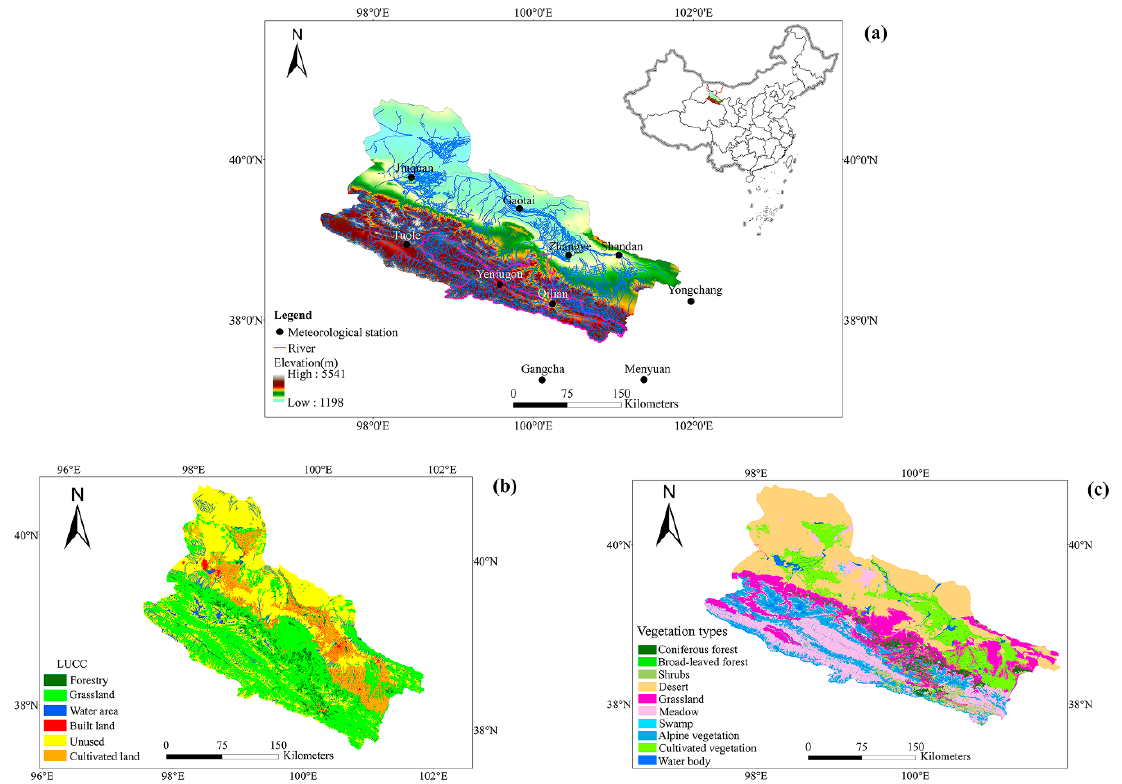
Figure 1. Location and meteorological stations ( a ), land use / cover (LUCC) for 2011 ( b ), and vegetation for 2011 ( c ) in the upper (UHRB) and middle (MHRB) reaches of the Heihe River Basin. Table 1. Details on the meteorological stations in the study area.